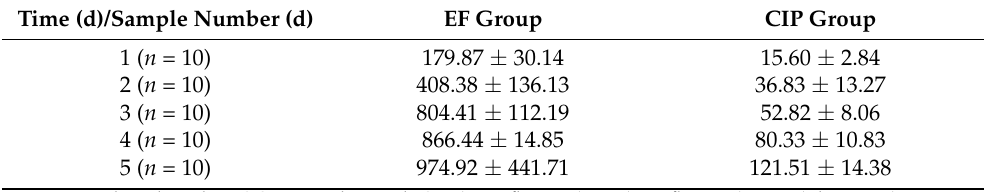
Table 4. Residual concentrations of EF during EF soluble powder in eggs (mean ± SD, n = 10) ( µ g/kg).